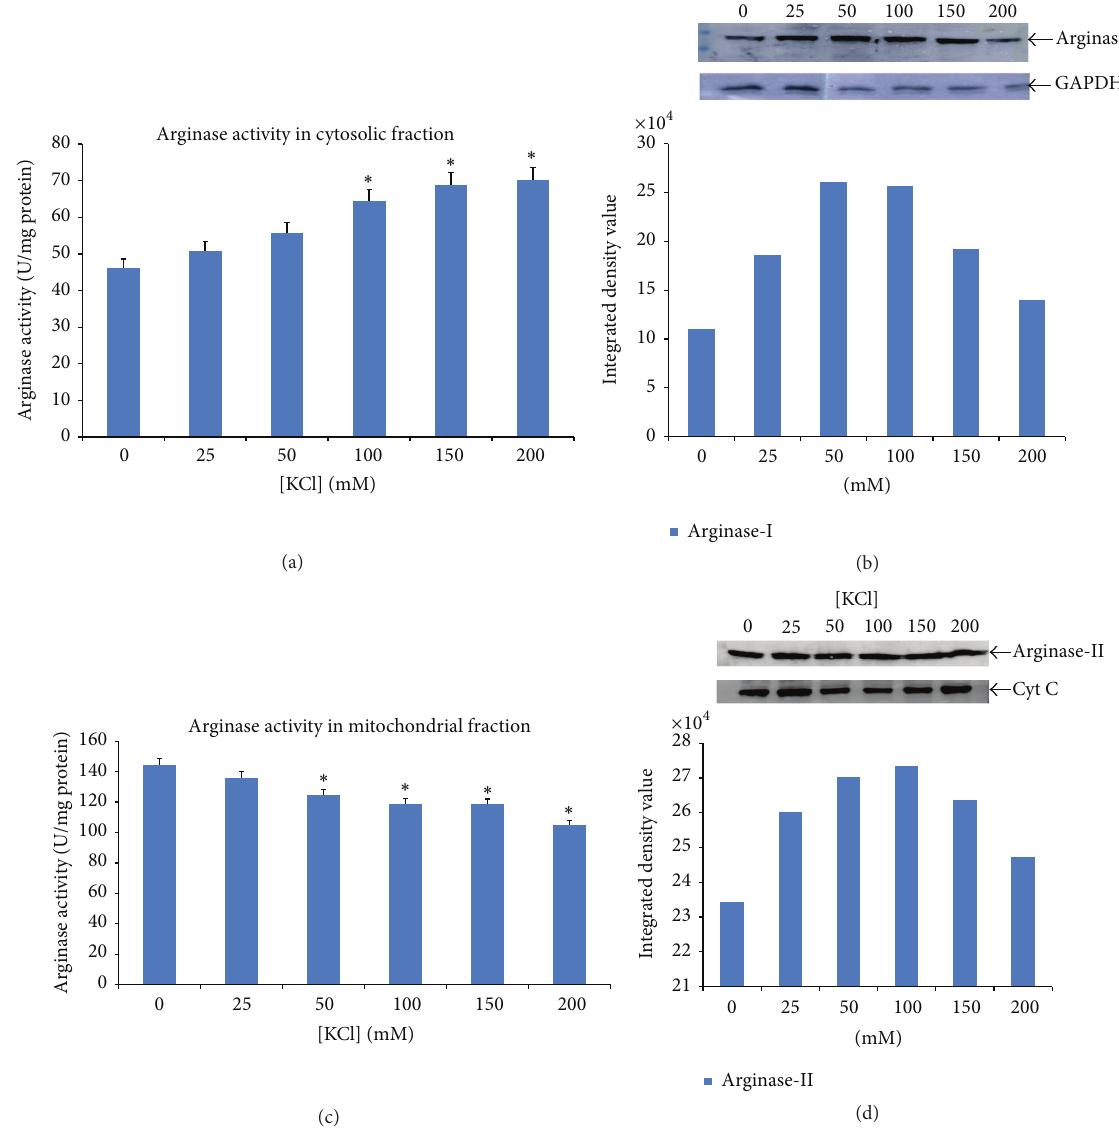
Figure 4: Showing impact of concentration of KCl in homogenizing medium on the activity of arginase. E1 shows the experimental set 1 described in the text. (a) The activity of arginase in cytosolic fraction. Data is mean of three experiments and histogram represents mean ± SD; ∗ 𝑃 < 0.05 . (b) The anti-arginase-I cross reacts with the single band of 40 kDa in cytosolic fraction and their activity increases with increasing KCl concentration in homogenizing medium. Glyceraldehyde 3-phosphate dehydrogenase (GAPDH) is taken as loading control. This result indicates the solubilisation of arginase-I proteins from the membrane of mitochondrial as well as other subcellular organelles. (c) The arginase activity decreases in the mitochondrial fraction with the increasing KCl concentration. But the percent decrease in the activity of the mitochondrial arginase-II is less than increase in the activity of cytosolic arginase-I; ∗ 𝑃 < 0.05 . (d) Anti-arginase-II has cross reactivity with the single band of the 40kDa of mitochondrial fraction. The intensity of this band was decreased with increasing KCl concentration. Cytochrome C (Cyt C) was taken as loading